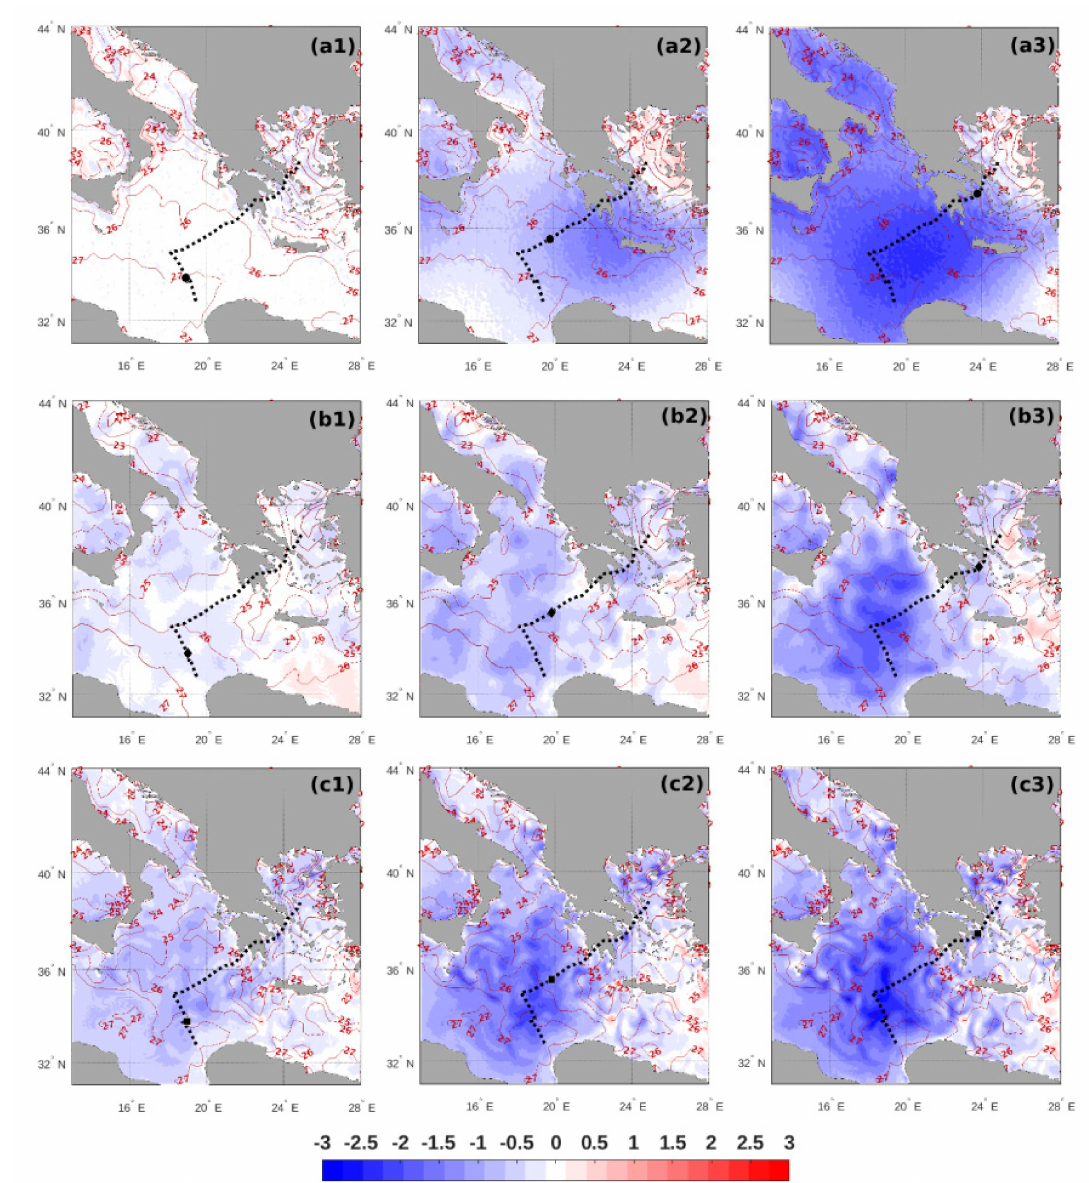
Figure 7. Di ff erences in SST (in ◦ C) spatial distribution between the 24 h, 48 h, and 72 h ahead and the initial field at 27 September 2019 at 00:00 UTC given in contour lines during cyclone Zorbas for ( a1 – 3 ) RTG-sst, ( b1 – 3 ) OSTIA-sst, and ( c1 – 3 ) NEMO-sst. Lines indicate storm tracks and mark the position of the lower mean sea level pressure (MSLP) 24 h, 48 h, and 72 h ahead from 27 September 2019 at 00:00